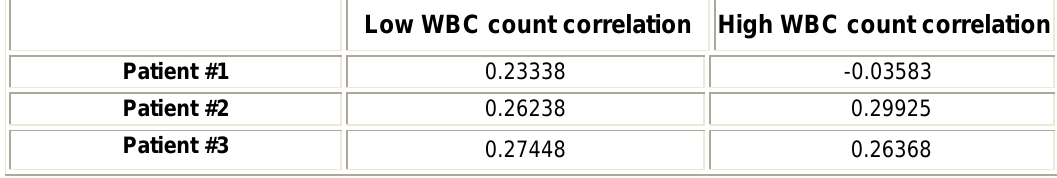
The correlation coefficients between WBC counts and dropping pain scores in the three